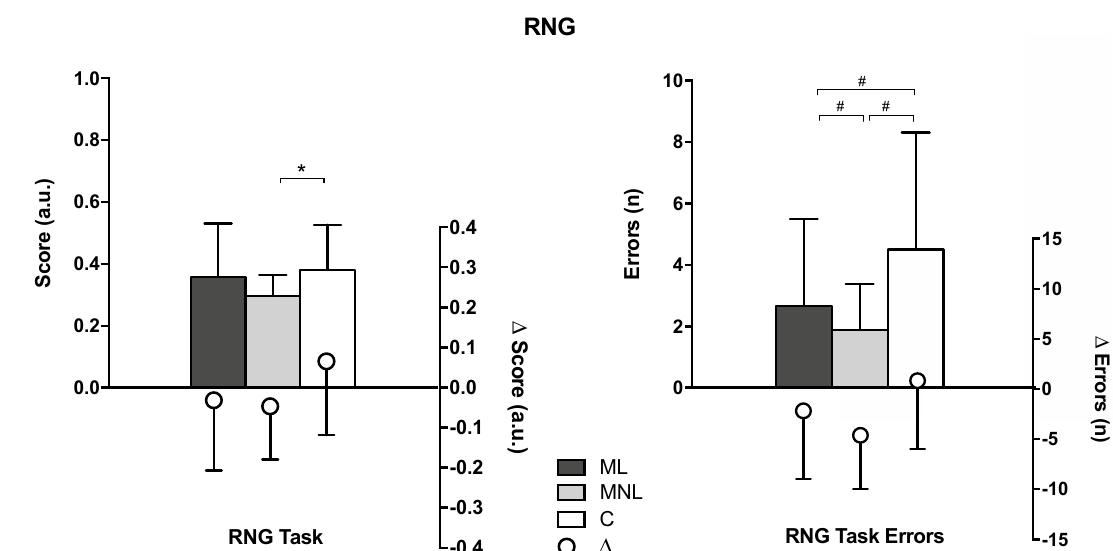
Figure 4. Effects of different teaching approaches on random number generation (RNG) after 12 weeks of intervention. ML = multi-teaching approach emphasizing linear teaching; MNL = multi-teaching approach emphasizing nonlinear pedagogy; C = control (conventional PE teaching by generalists); Δ = within-group post-intervention changes compared to baseline. “a.u.” = arbitrary units. Significant values are shown: # = p < 0.05 (analysis performed on ∆ after-before intervention because homogeneity at baseline was not met); * = p < 0.05 (analysis performed on post-intervention measures as baselines were homogeneous). Figure 5 and Table 2 show the PAQ-C, PSES, and PACES questionnaire results. PAQ-C and PACES showed no differences by teaching approach, whereas MNL obtained the best PSES scores, significantly higher than those of ML or C.